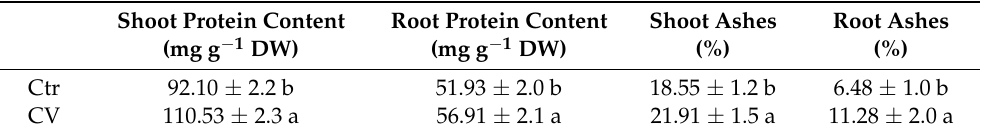
Table 4. Total protein and ashes contents in leaves and roots of lettuce seedlings subjected to Chlorella vulgaris extract (CV) treatment after 21 days from the first treatment. Data are means ± SD. The values are the means of data from five replications. Values in the same column followed by different letters are significantly different ( p < 0.05). Ctr: